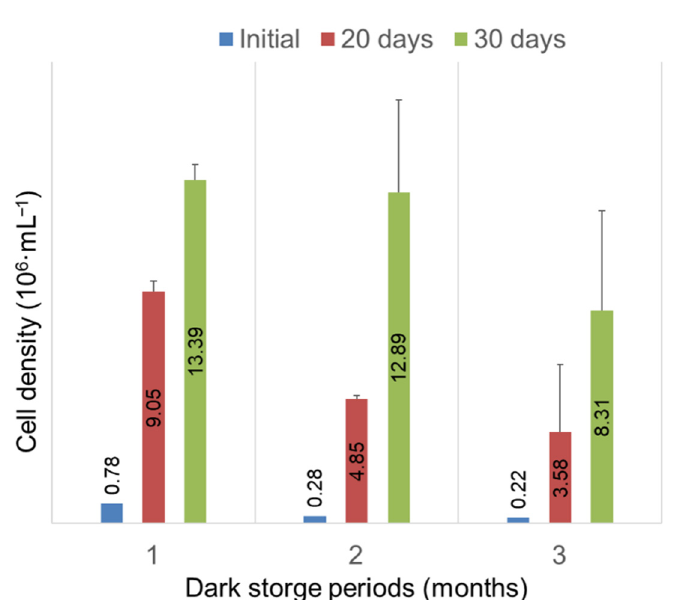
Figure 5. Cell density recovery of A. anophagefferens strain CCMP1984 after the cultures were stored in the dark at 4 °C for 1 to 3 months. Cell densities were quantified microscopically at the time points of 0 (immediately after inoculation), 20, and 30 d after the dark-stored resting cells were inoculated to fresh f/2-Si medium and incubated at the conditions (12:12 h photoperiod, 21 °C, 100 μ mol photons m − 2 ·s − 1 ) that were used for the routine maintenance of cultures. Each data point was shown as mean ± SD (standard deviation) from triplicate samples.